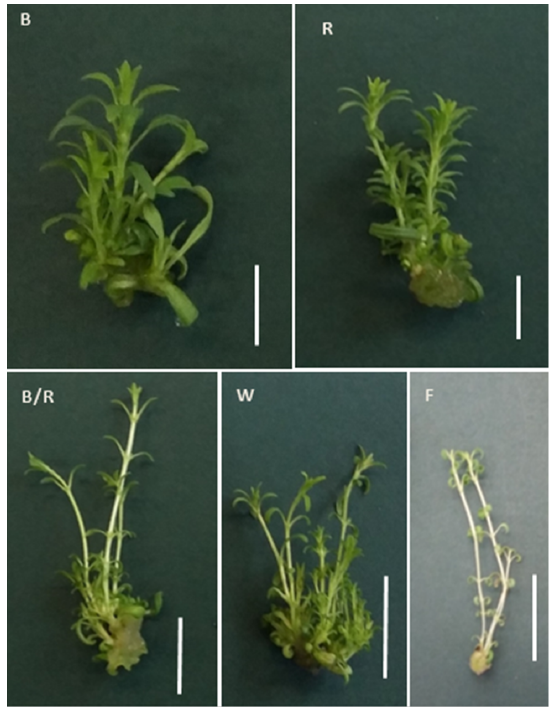
Figure 3. Morphology of D. forrestii shoots cultured under various light conditions: ( B ) blue, ( R ) red, ( B/R ) blue/red, ( W ) white, ( F ) fluorescent. Bar 1